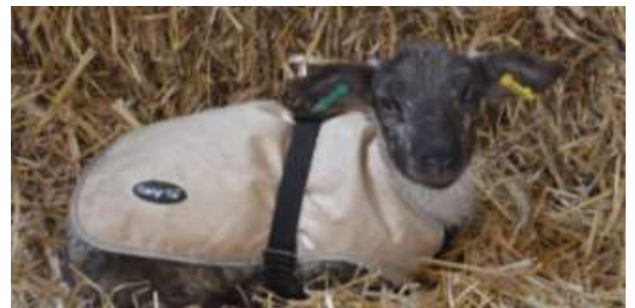
Figure 2. Lamb in jacket showing the fastening strap.